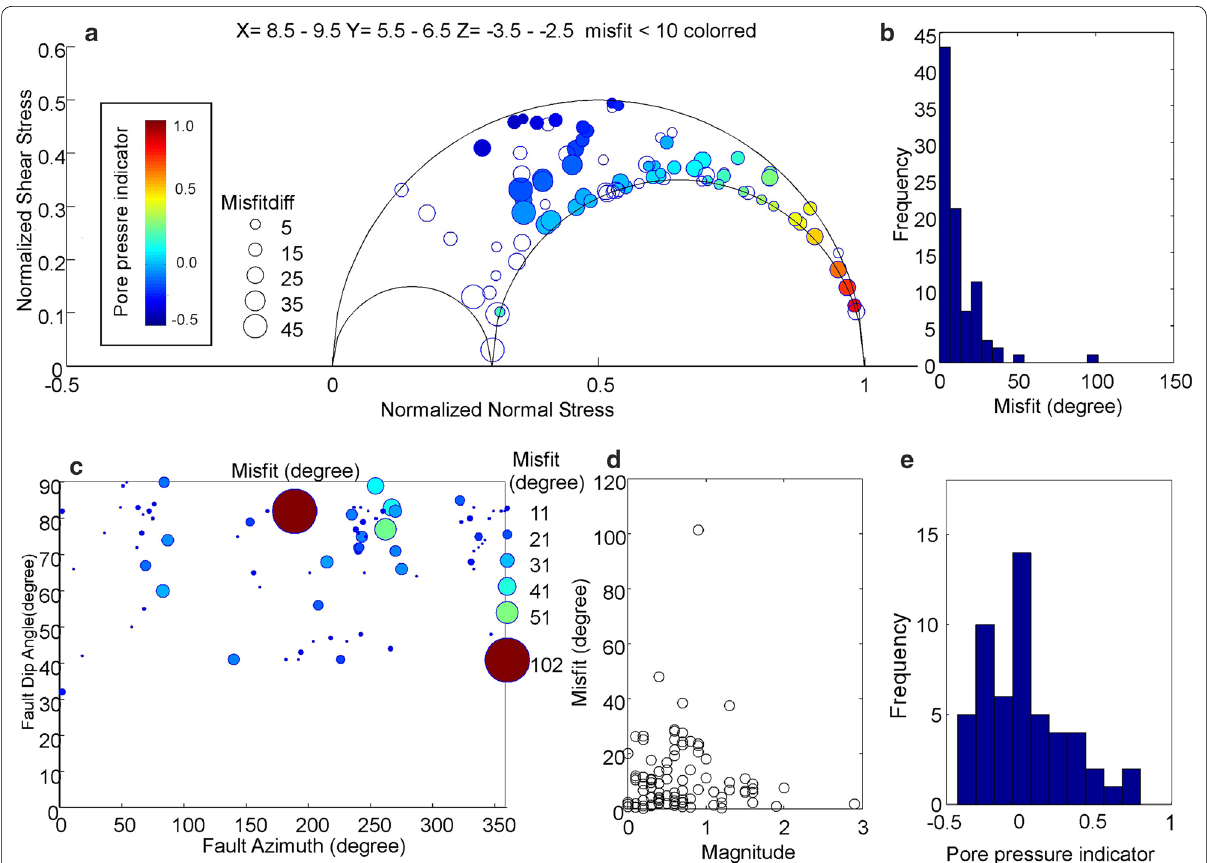
Fig. 12 a Plots of the normalized shear and normal stresses on a three‑dimensional Mohr diagram for a grid point ( x gram of misfits. c Relationship between azimuths and dip angles of the fault planes. d Relationship between magnitude and misfit. e Histogram of the pore pressure indicator P p . Other explanations are the same as for Fig.